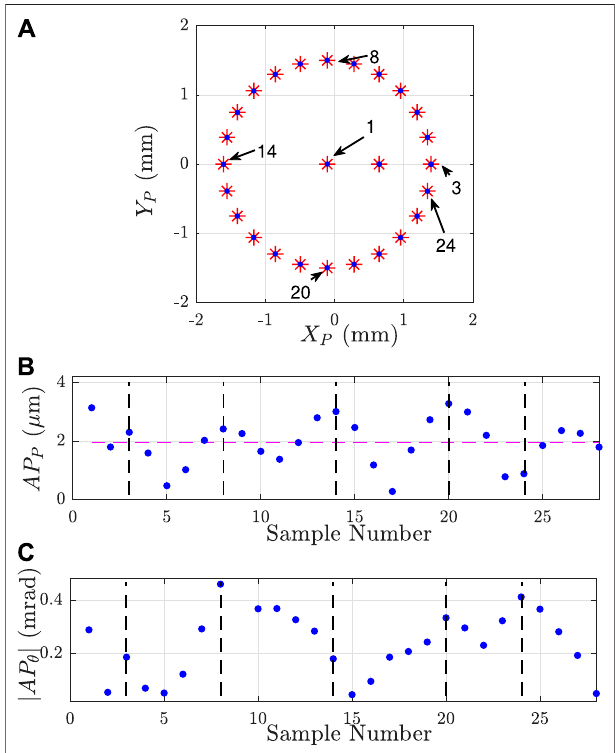
FIGURE 12 | Result of the robot position control for a circular trajectory (A) commanded poses (in red) and attained with the prototype (in blue) (B) position and (C) orientation accuracies obtained for the different poses. The horizontal dashed-line is the mean value of the positioning accuracy whichis1.95 µm. Theblackdashed-lines arecharacteristicpoints (numbered points) on the trajectories where the AP P or AP θ monotony change.